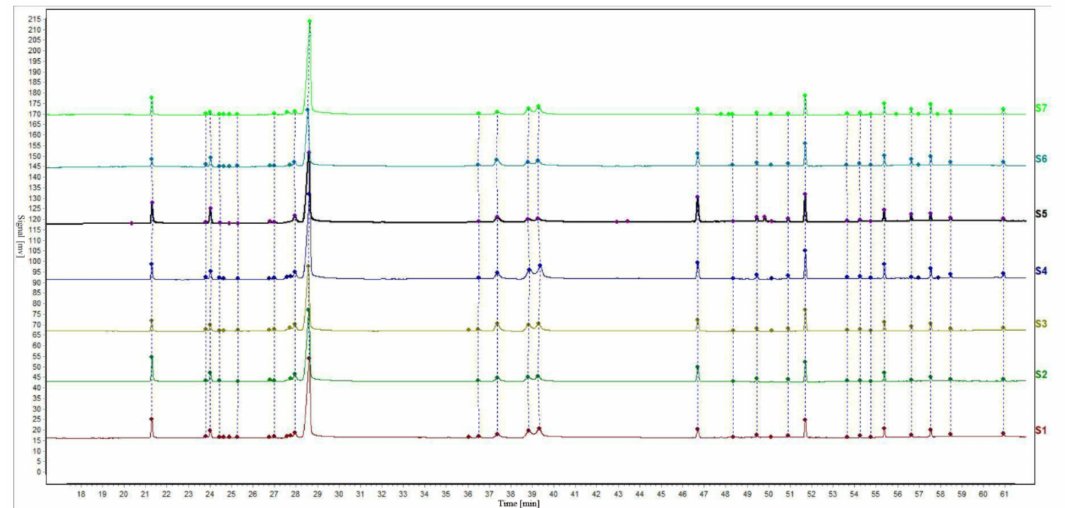
Figure 2. Gas phase fingerprint of essential oil from S. chamaejasme flowers. Table 4. Evaluation results of fingerprint similarities of essential oil from seven batches of S. chamaejasme flowers. Sample Batch